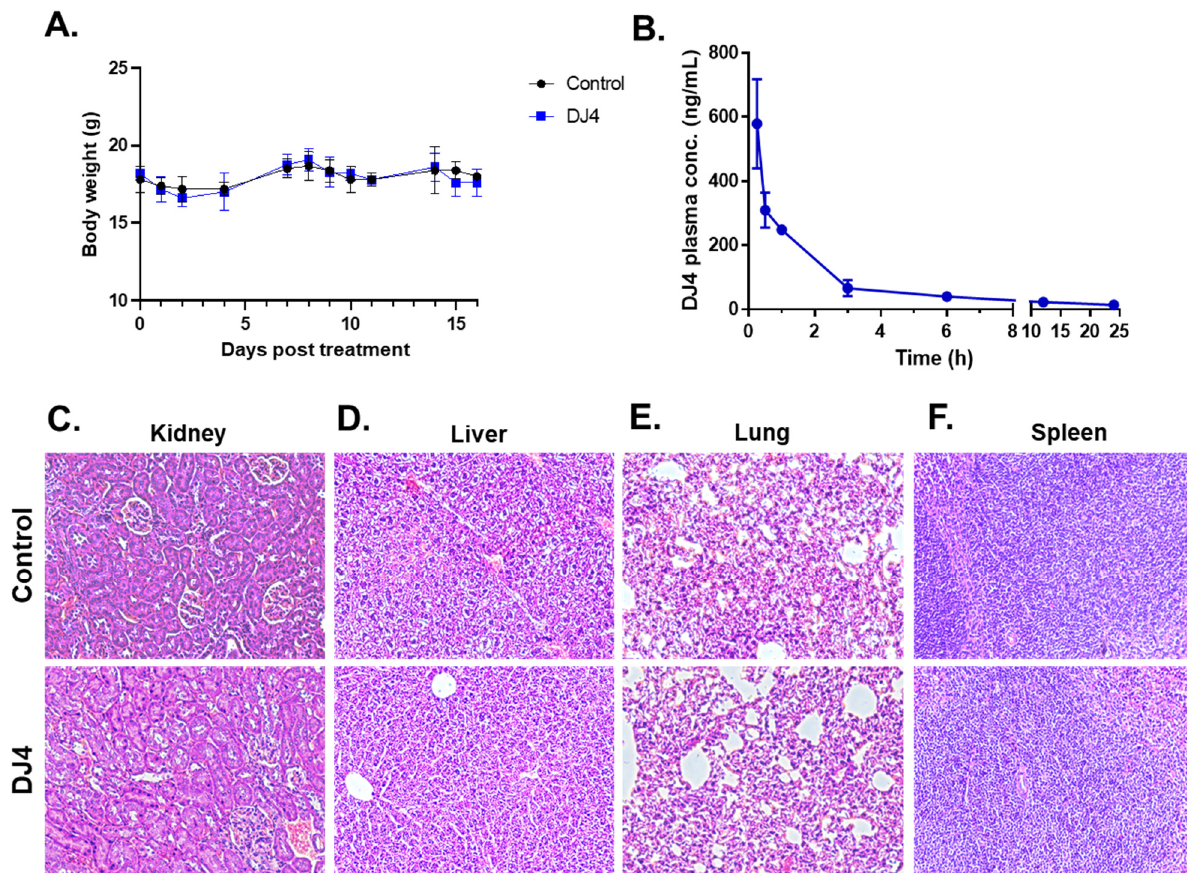
Figure 5. Intraperitoneal administration of 10 mg/kg DJ4 for 2.5 weeks was tolerated in the mice without systemic toxicity. ( A ) The weights (g) of the mice treated with the vehicle versus DJ4 were comparable. The values are represented as the means ± SD ( n = 5, see Table S2 for the average body weight values). ( B ) Pharmacokinetic analysis to quantify the concentration of DJ4 in the serum of the treated mice at various time points (0.15–24 h). The values are represented as the mean ± SEM ( n = 3). ( C – F ) Cross-sections of kidney ( C ), liver ( D ), lung ( E ), and spleen ( F ) tissues from the mice treated with DMSO (top) and DJ4 (bottom) that were formalin-fixed, paraffin-embedded, and hematoxylin-and eosin-stained to examine the cell or organ morphology. Magnification: 20 ×